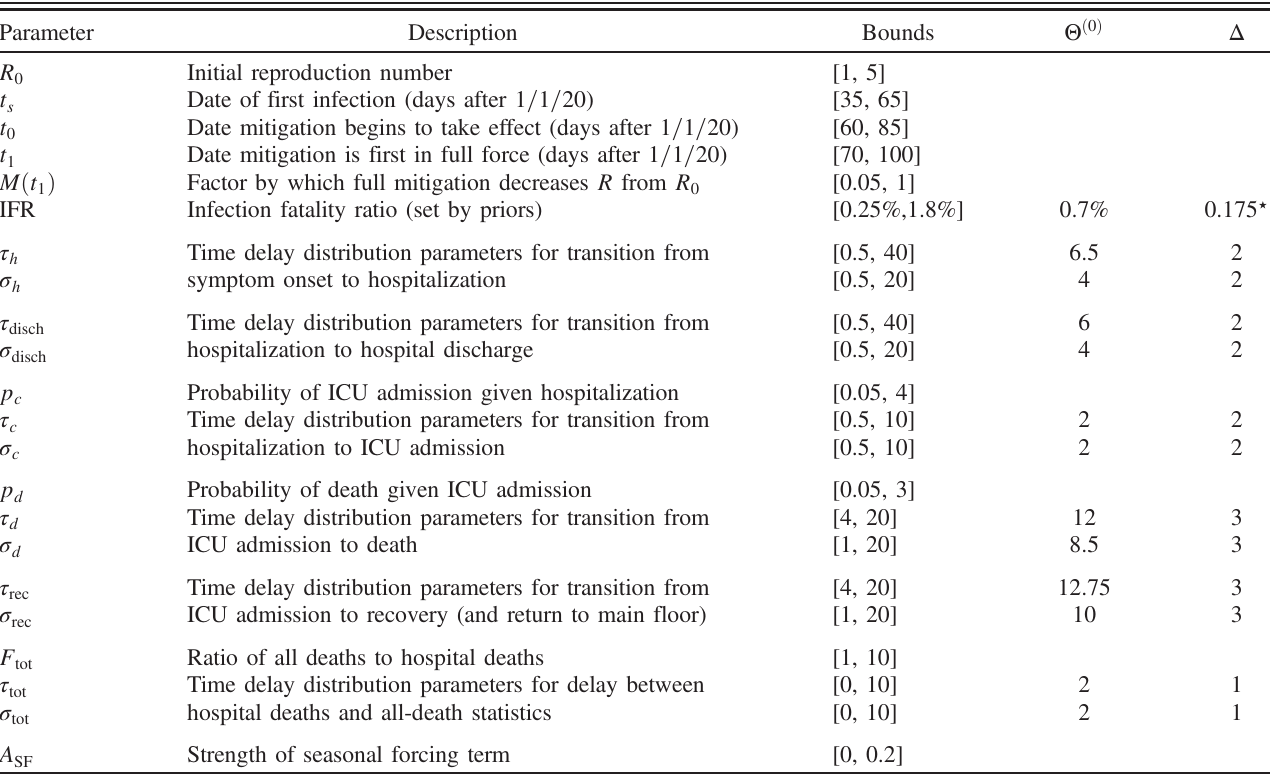
TABLE I. Specification of sampler parameters and their priors. The mean and standard deviation of a delay-time PDF K x are reported in days and denoted by τ x and σ x , respectively, and probabilities p x denote the overall scaling of the age distribution p x;i as specified in Table II. In addition to the listed bounds on the various scaling factors p x , we also enforce that the number of individuals drawn from a state does not exceed the total number presently in that state. We indicate strict bounds on parameter values and provide the mean Θ ð 0 Þ and standard deviation Δ for parameters ’ Gaussian priors where specified. Our priors on K Refs. [28 – 32], and we use Ref. [33] to set our prior on lnIFR. The * indicates that we implement a Gaussian prior for lnIFR, with mean corresponding to IFR ¼ 0 . 7% and variance of lnIFR set to